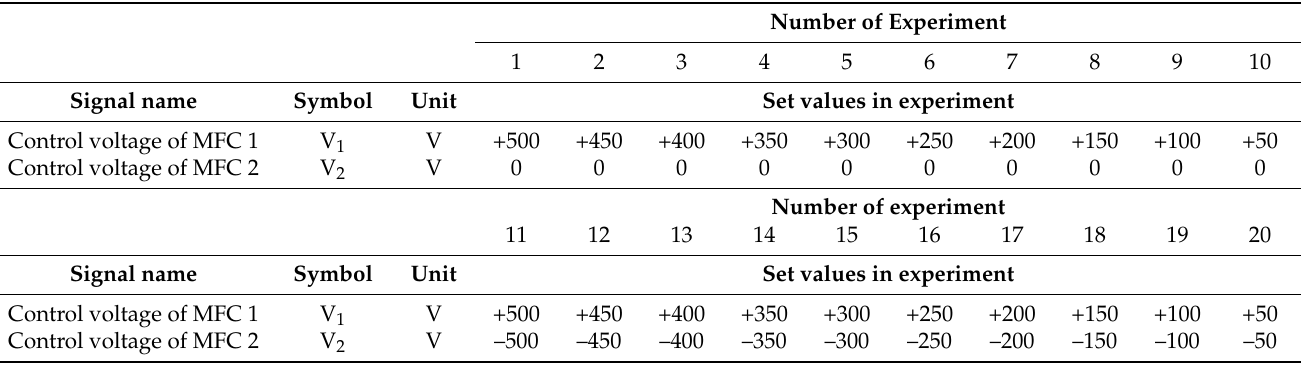
Figure 7. Courses of set values of control signals in proper research: ( a ) experiments 1–10, ( b ) experiments 11–20. Table 2. Set values of control signals in laboratory